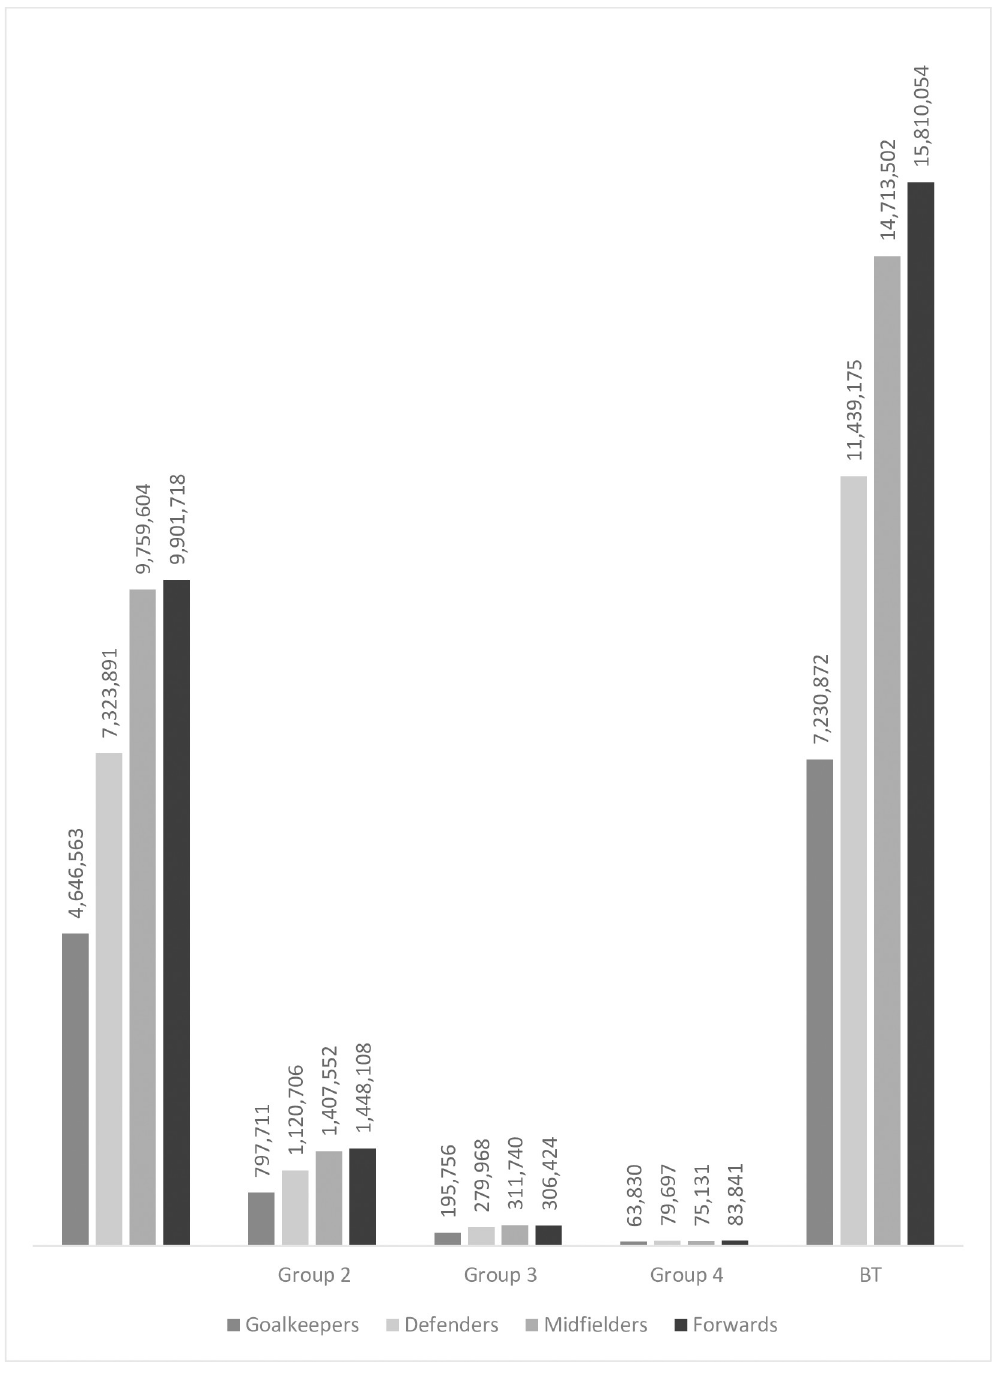
Fig 5. Relationship between the player’s playing position and transfer